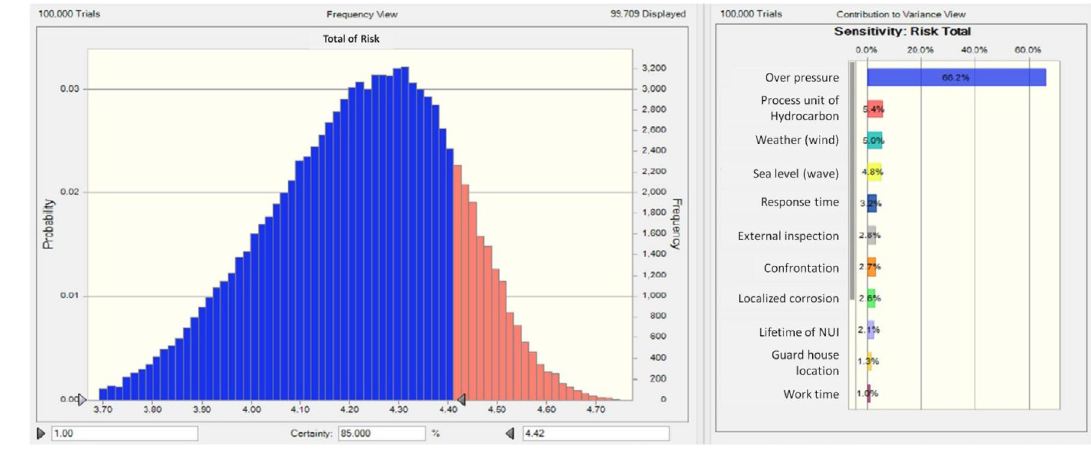
Fig. 7 Total risk values for a type B platform Table 10 Mapping of risk value Low Risk Medium risk High risk Broadly acceptable region The ALARP or tolerability region